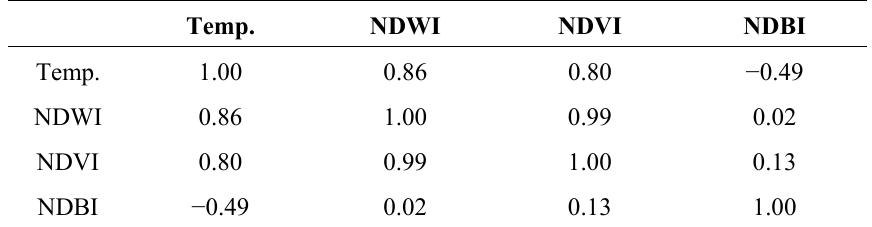
Table 4. Correlation matrix of the mean values from the indices and LST in a vegetation cover pattern. Temp. NDWI NDVI NDBI Temp.